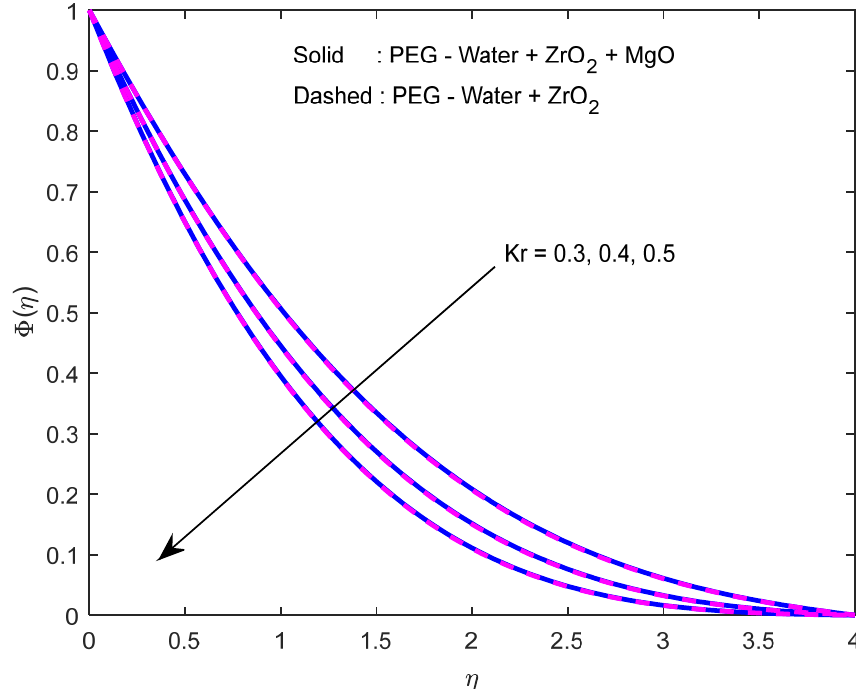
Figure 14. Effects on concentration due to Kr .